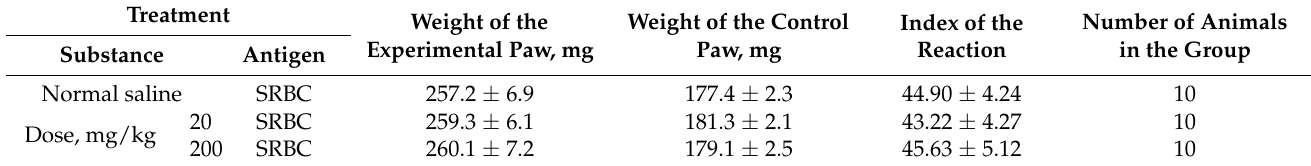
Table 6. The effect of the substance on the reaction of the delayed-type hypersensitivity in mice.